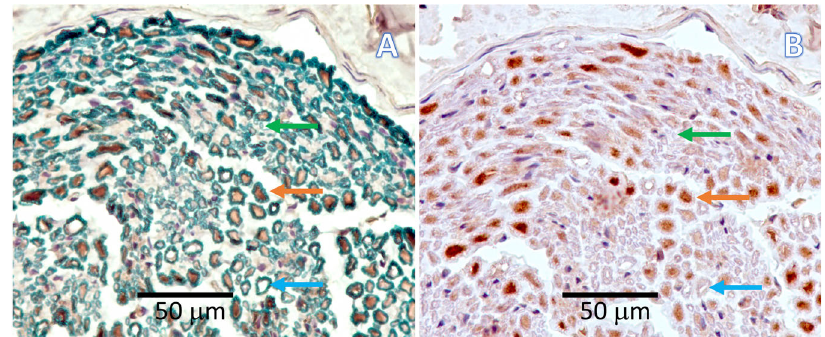
Fig. 6 A An on-slide procedure for the sequential double non- fl uorescent immunostaining on paraf fi n sections (RNS: reciprocal nerve staining) showed a good contrast between choline acetyl- transferase reaction product of motor fi bers (light brown arrow) and